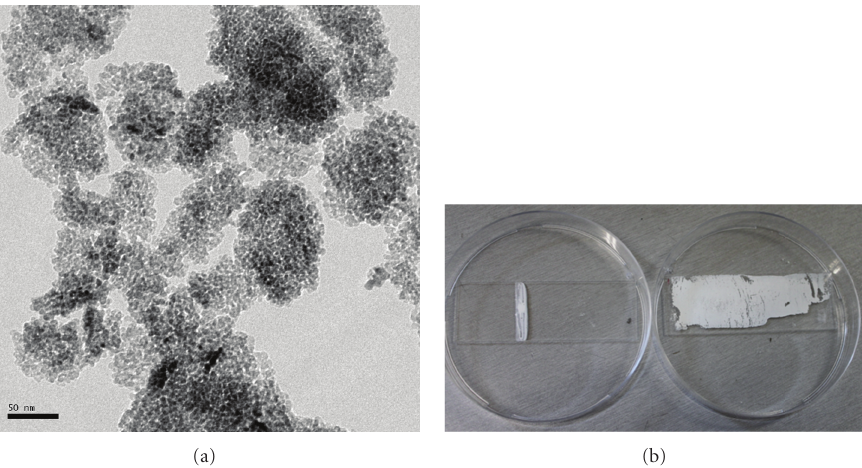
Figure 1: (a) TEM image of TiO 2 nanoparticles, (b) thin films prepared on glass surfaces using convective assembly and drop-casting.